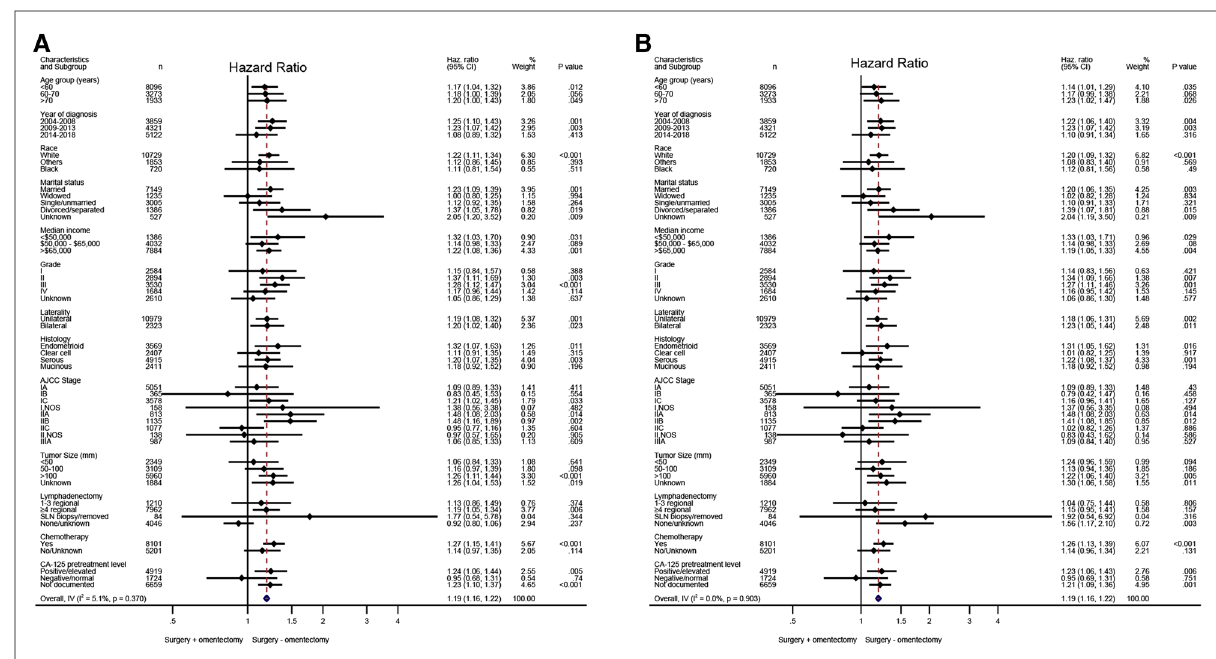
FIGURE 2 Exploratory subgroup analysis concerning omentectomy impact on survival outcome in the whole cohort. ( A ) Cause-speci fi c survival before IPTW adjustment. ( B ) Cause-speci fi c survival after IPTW adjustment. ( D ) Overall survival after IPTW adjustment. CI, con fi dence interval; HR, hazard ratio; IPTW, inverse probability of treatment weighting. The vertical solid line refers to a hazard ratio of 1.0. HR<1 favors surgery without omentectomy and HR>1 favors surgery with omentectomy. A score value of P <0.05 indicates statistical signi fi cance.